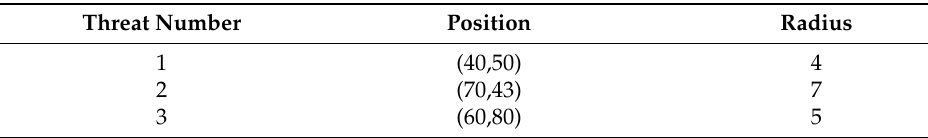
Table 6. Threat information.